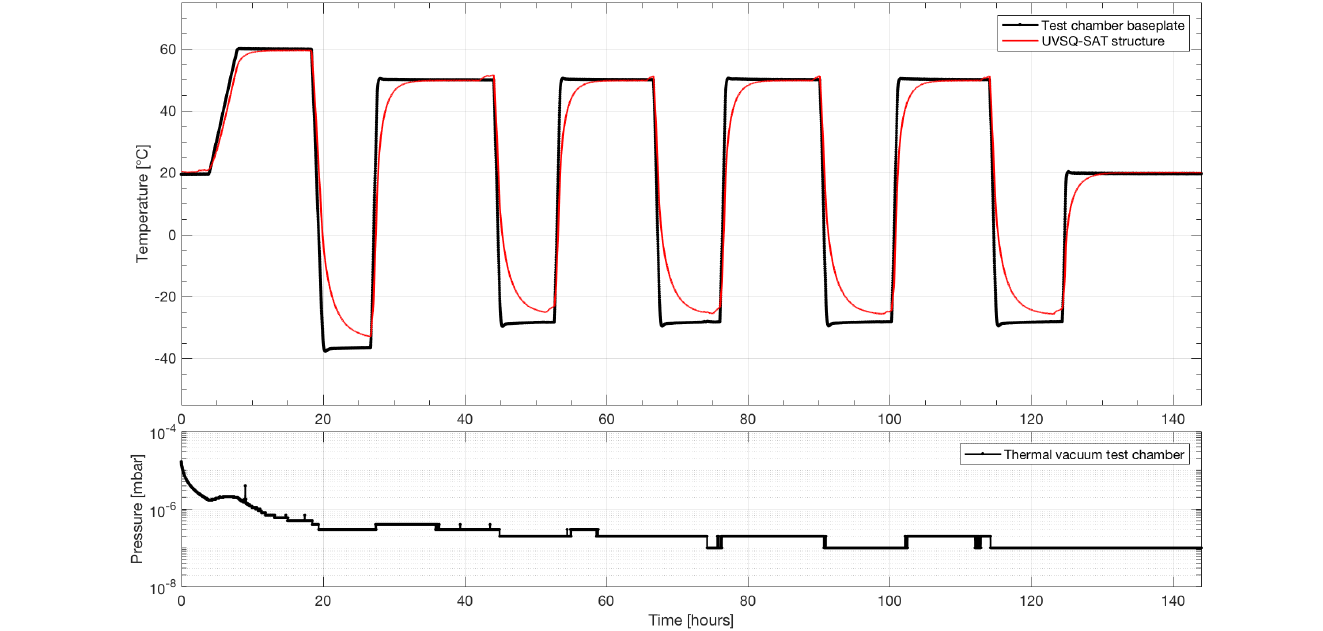
Figure 4. Profile of the UVSQ-SAT thermal vacuum cycling tests carried out in September